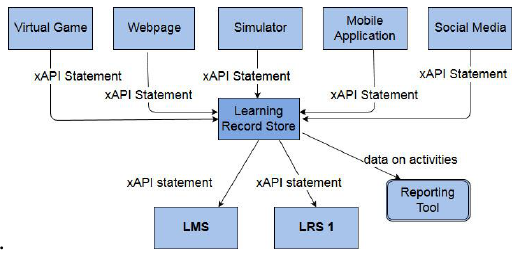
Figure 1. xAPI supports a distributed architecture, where statement streams can originate from diverse sources and may be delivered to several